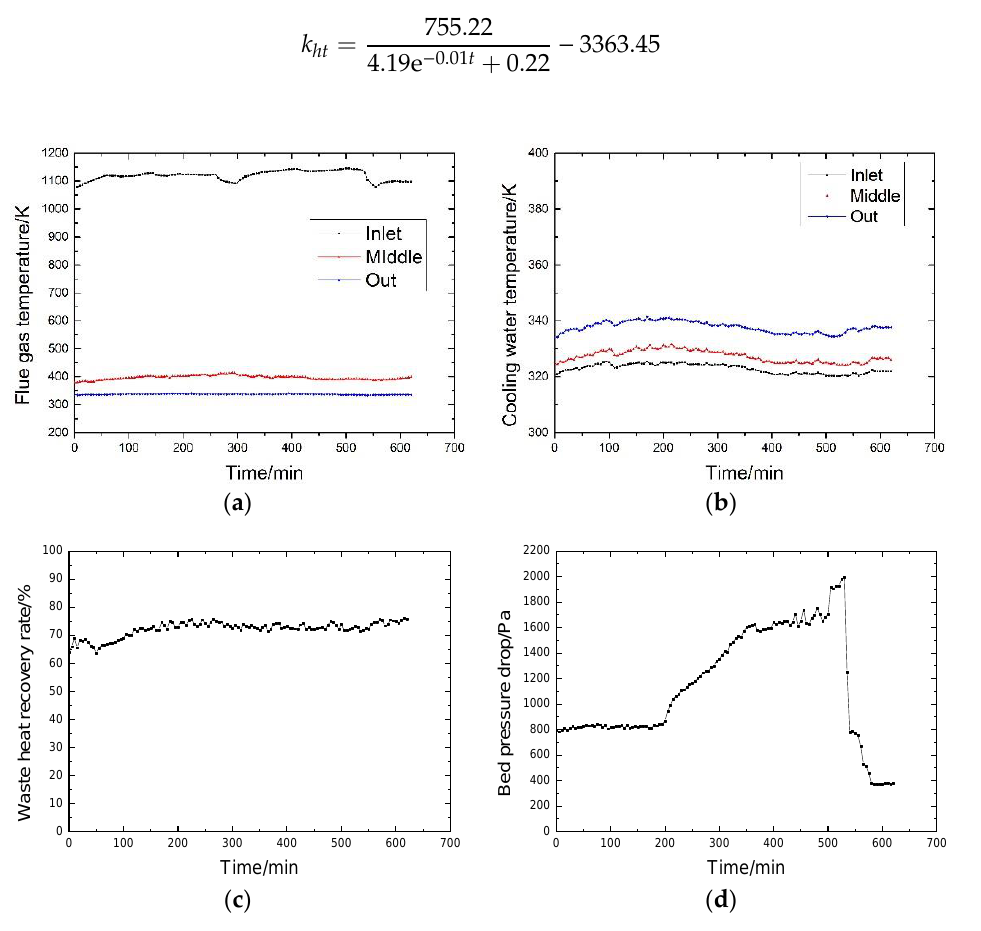
Figure 3. Variation curves of heat exchange in the buried tube granular bed. ( a ) Variation curve of flue gas temperature. ( b ) Variation curve of cooling water temperature. ( c ) Variation curve of waste heat recovery rate. ( d ) Variation curve of bed pressure drop.